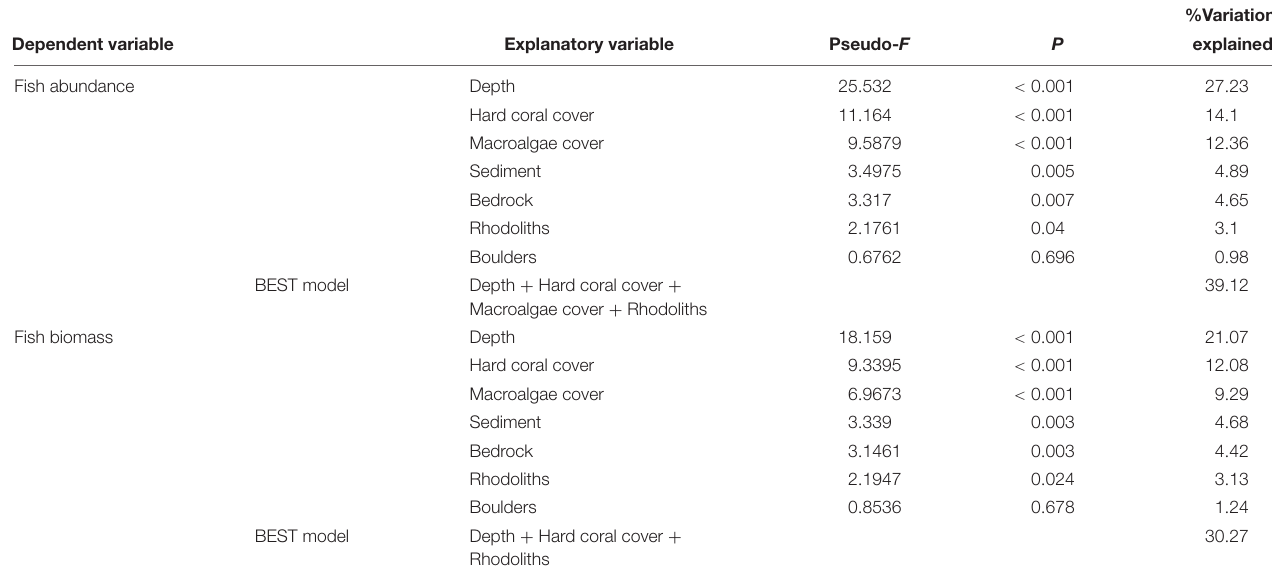
TABLE 3 | Percentage of variation explained by benthic cover and substratum composition in a distance-based multilinear model for reef fish communities using subsets of abundance and biomass